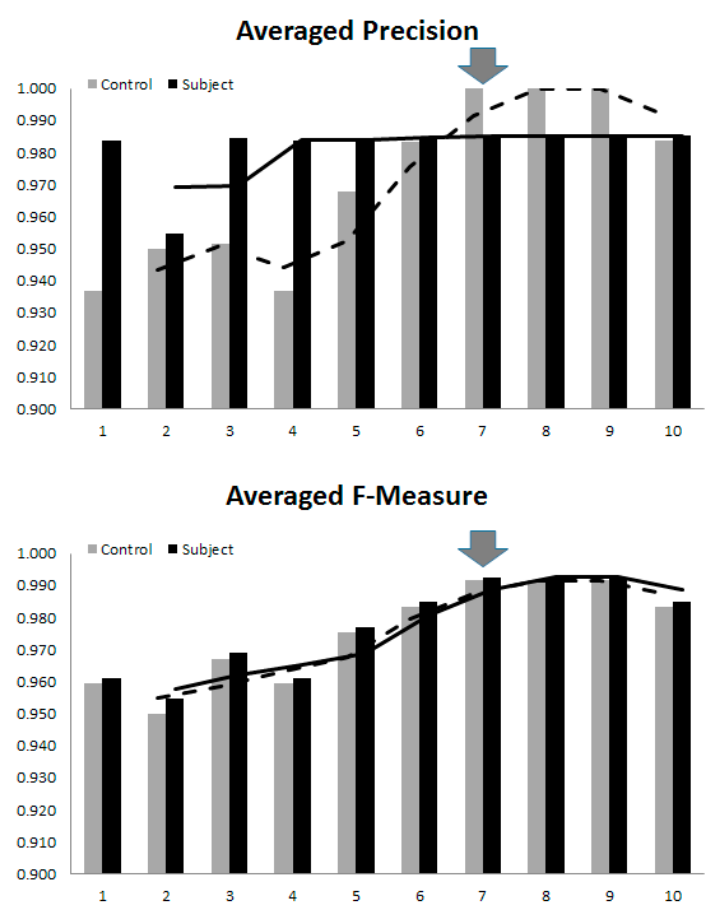
Figure 8. The overall trend of clustering performance versus the model complexity. The arrows indicate the optimal number of model parameters for diagnosing early AD.